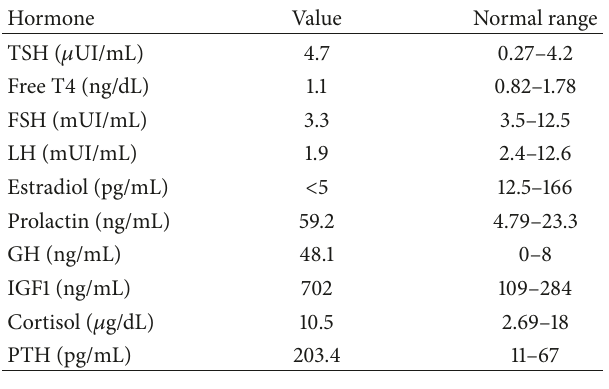
Figure 2: (CT) tail of pancreas with hypervascular heterogeneous and well-defined mass with lobulated edges measuring 6.8 × 7.7 × 6.4